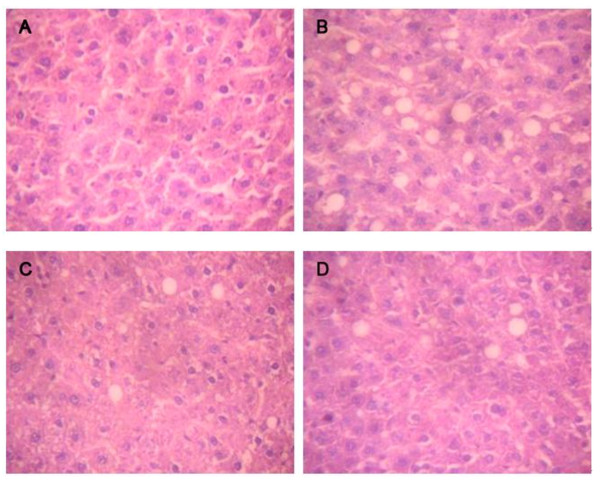
Histology of liver steatosis in the four groups. A: normal diet; B: high-cholesterol diet; C: high-cholesterol diet + L. plantarum 9-41-A; D: high-cholesterol diet+ L. fermentum M1-16. All the photomicrographs show HE staining (original magnification × 400).